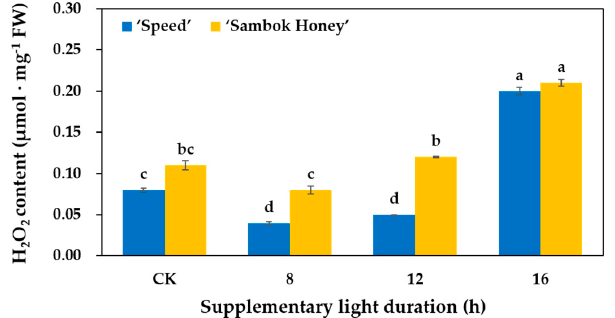
Figure 6. The e ff ects of the supplementary light duration on the hydrogen peroxide content (H 2 O 2 ) of two cultivars of watermelon seedlings, ‘Speed’ and ‘Sambok Honey’, grafted onto ‘RS Dongjanggun’ bottle gourd rootstocks, after 10 days of supplementary light treatments. The error bars represent the SEs of biological replicates ( n = 3). Mean separation within columns are significantly di ff erent according to Tukey’s multiple range test at p = 0.05.